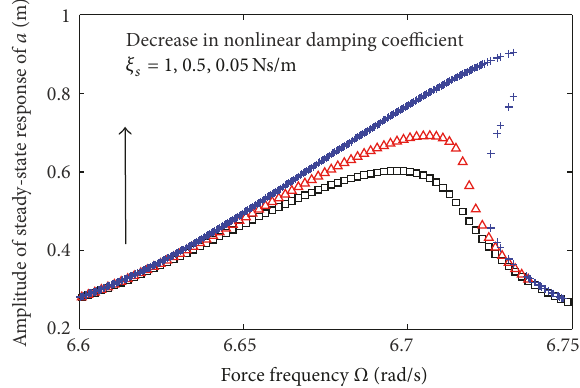
Figure2:Theeffectofvaryingacceleration 𝑓 onfrequencyresponse of vibration 𝑎 . 𝑓 = 2 m / s 2 (black squares) and 𝑓 = 6 m / s 2 (red triangles), 𝑓 = 10 m / s 2 (blue crosses).